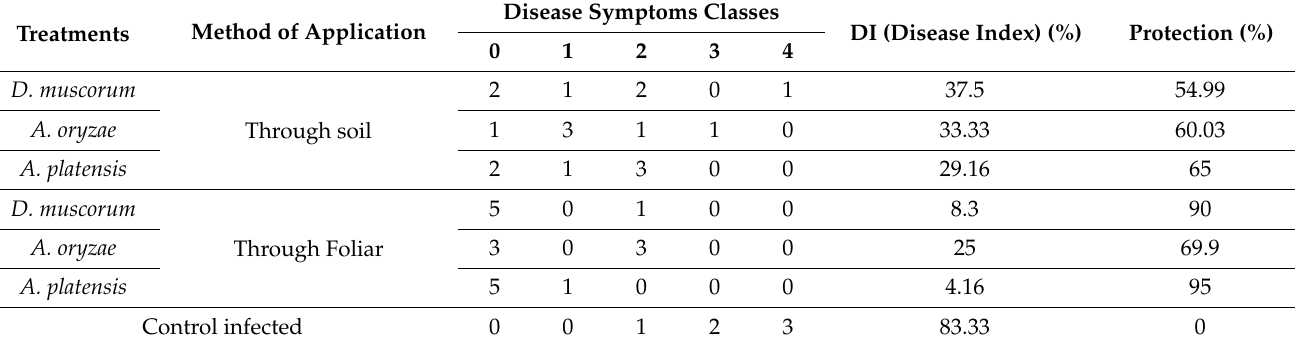
Table 1. Effect of cyanobacteria on disease index of the infected pepper plant with Fusarium wilt.